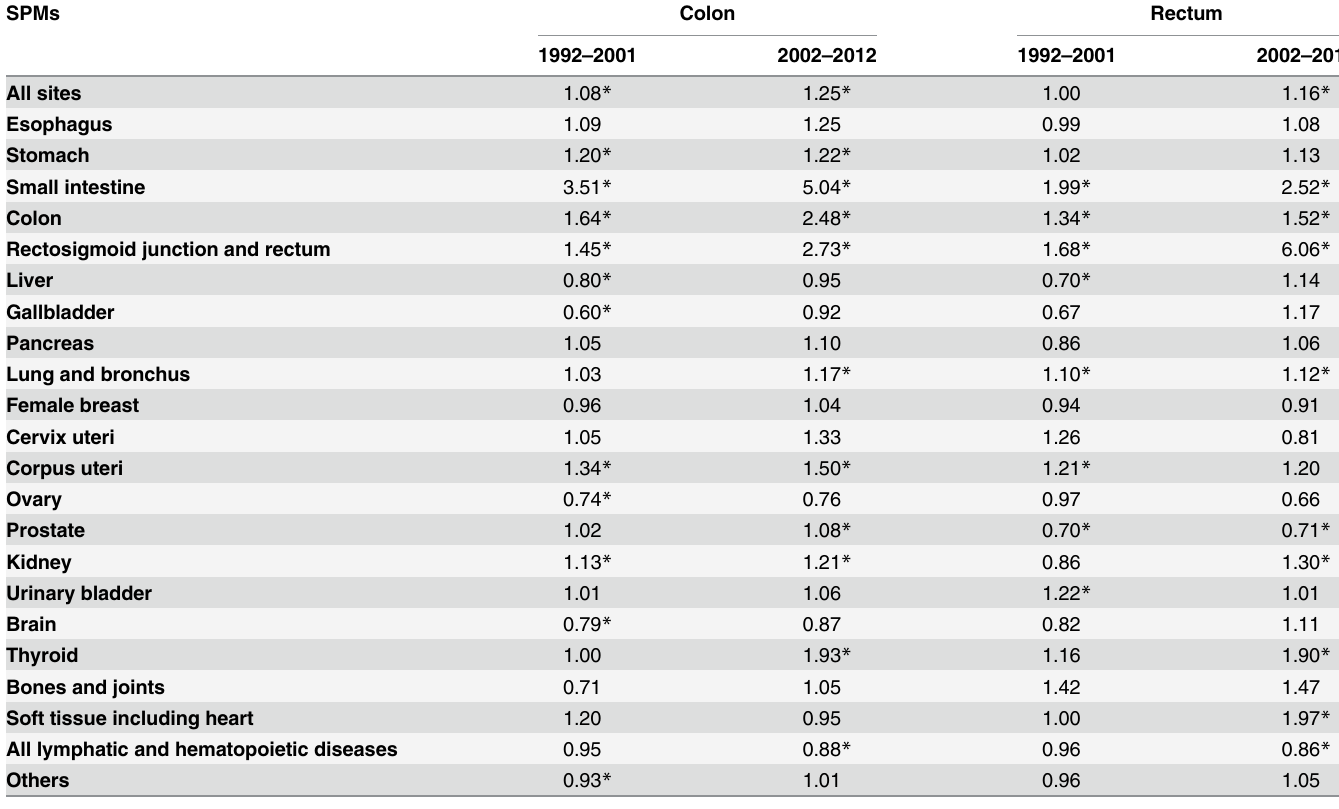
Table 6. SIRs of SPMs in colon and rectal cancer patients, by calendar year. SPMs